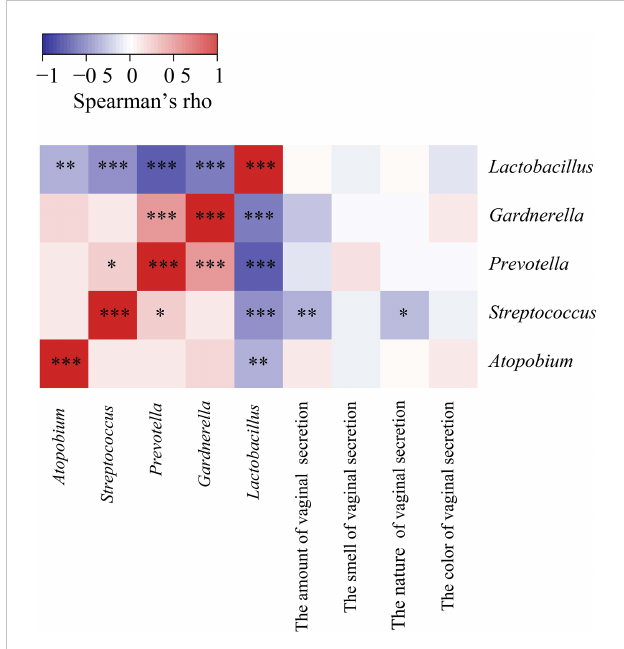
FIGURE 5 Spearman ’ s Correlation heat maps showing association between dominant bacteria and properties of subjects ’ vaginal secretion. The color scale shows the strength of correlation (ranging from 1 to -1, representing strong positive to strong negative correlation). * P < 0.05, ** P < 0.01, and *** P < 0.001.